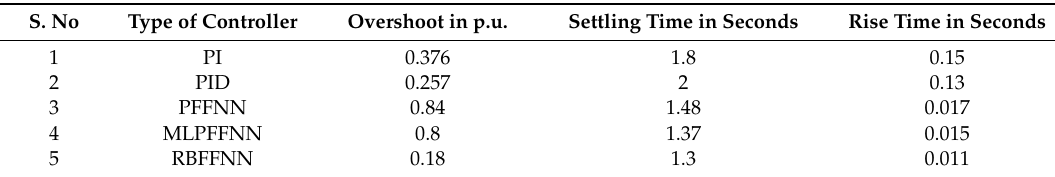
Table 3. Reactive power at stator side.